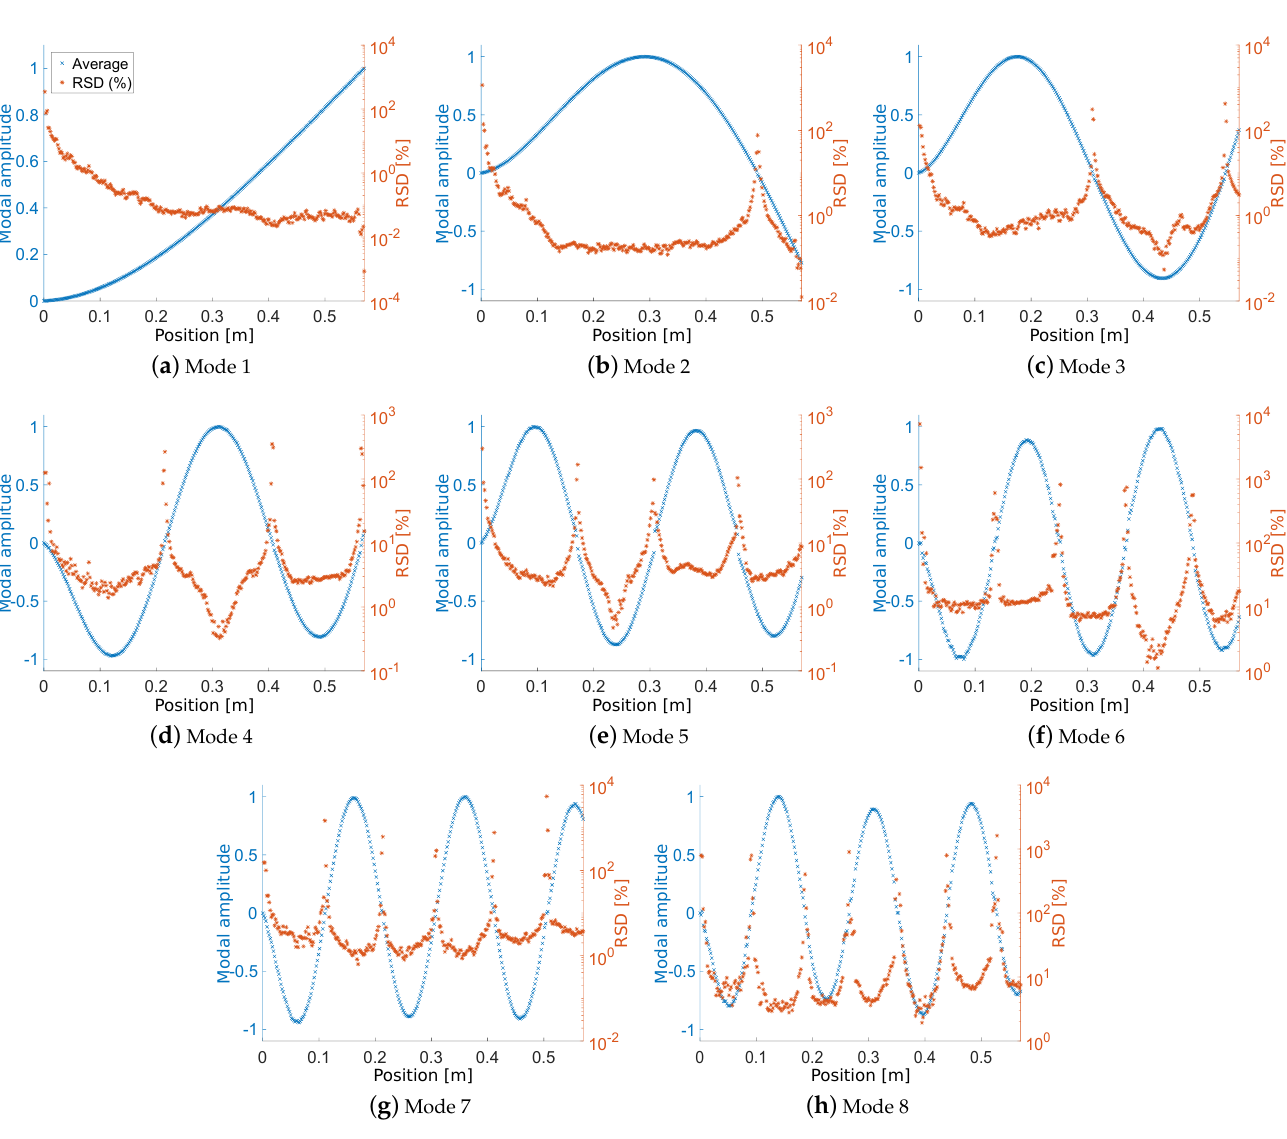
Figure 22. First eight mode shapes obtained from the DIC measurements for the cantilever beam. Table 4. Frequencies of the cantilever beam determined for the different tests from DIC measurements and accelerometers (in